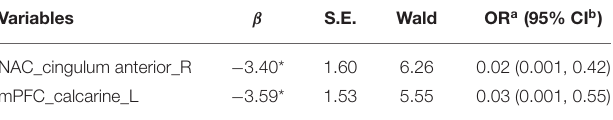
TABLE 3 | Multivariate logistic regression models to predict relapse ( n =